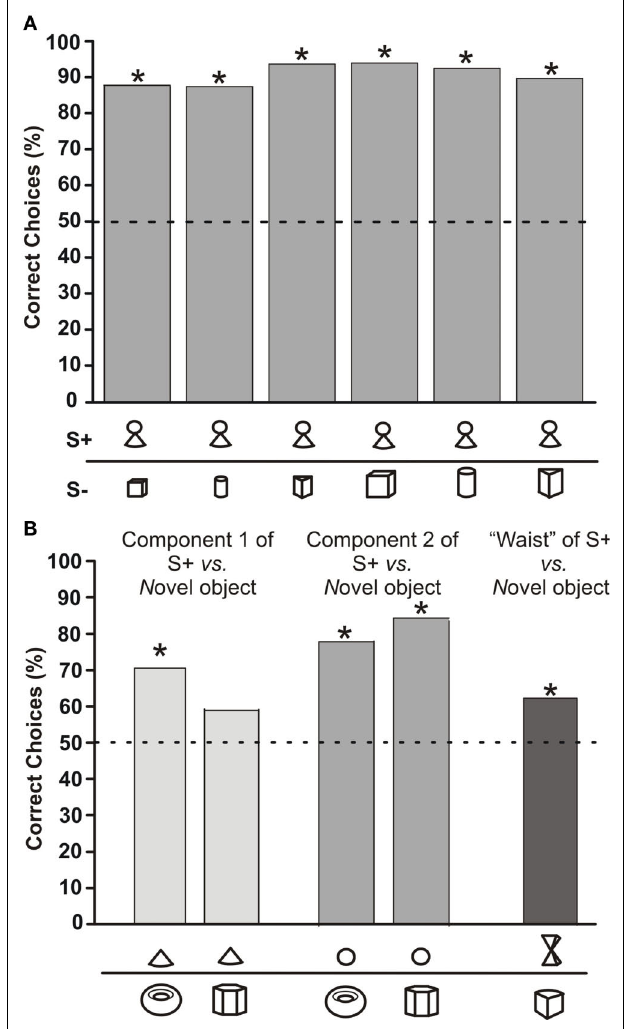
FIGURE 3 | (A) Choice frequency for S + of a G. petersii trained to discriminate between a fi xed S + (‘little man’) and six differently shaped objects, symbols of which are shown below each bar along the abscissa. The total number of choices recorded for each column was above 132. (B) Choice frequency of the same fi sh as in (A) when components of the former S + were presented with other previously unseen objects. Symbols below each column show the object combination used, with the object above depicting the S + and the object below the alternative objects used in the tests. N > 44 test trials per